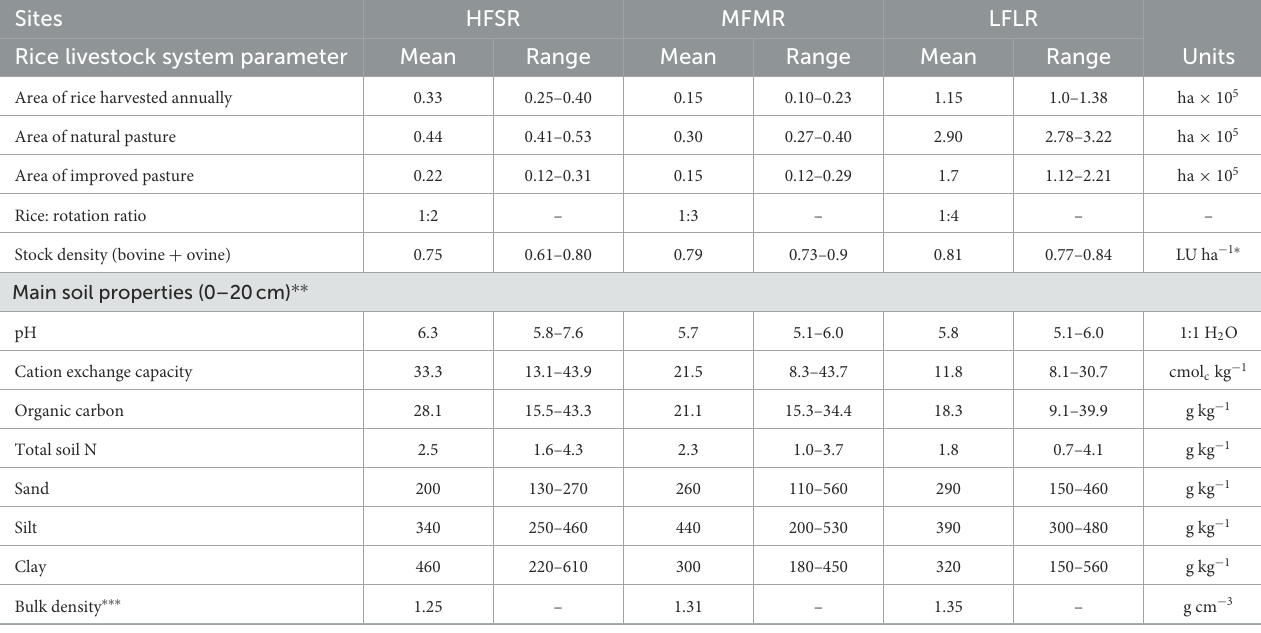
TABLE 1 Components of the rice–livestock system of Uruguay at a regional level.